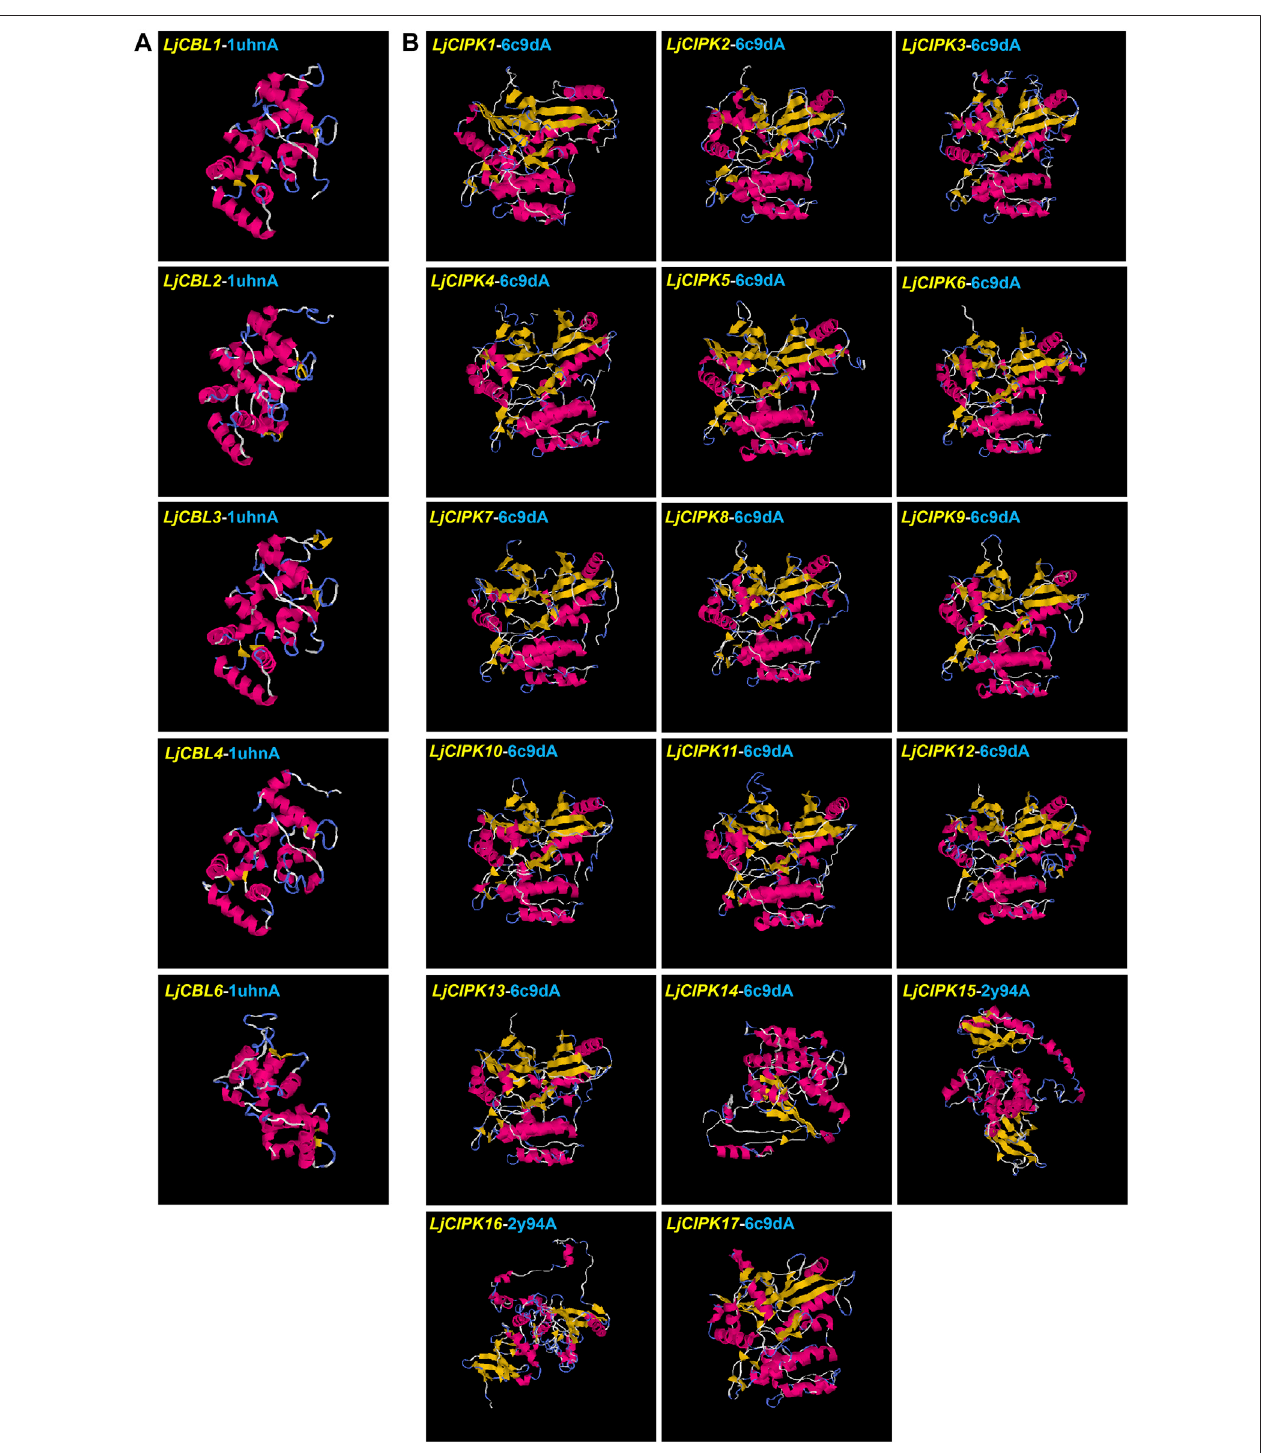
FIGURE 4 | Structural analysis of six LjCBL (A) and seventeen LjCIPK (B) modeled proteins. The α -helix, β -strand, and random coil are marked by red, yellow and blue, respectively. The parameters of the best PDB structure for LjCBLs and LjCIPKs are listed in Table 3 . Details of secondary structure are shown in Supplementary Figures S3,S4